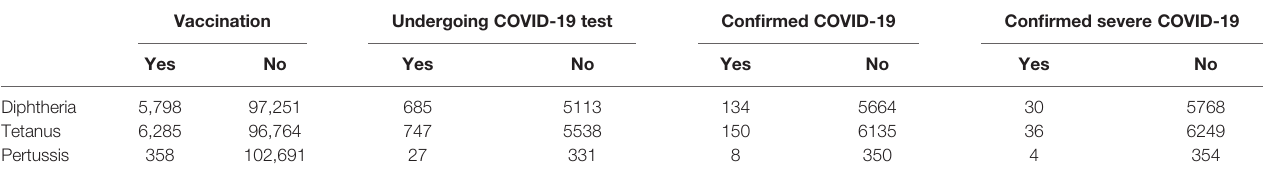
TABLE 1 | Number of individuals per vaccination group for each of the study outcomes.